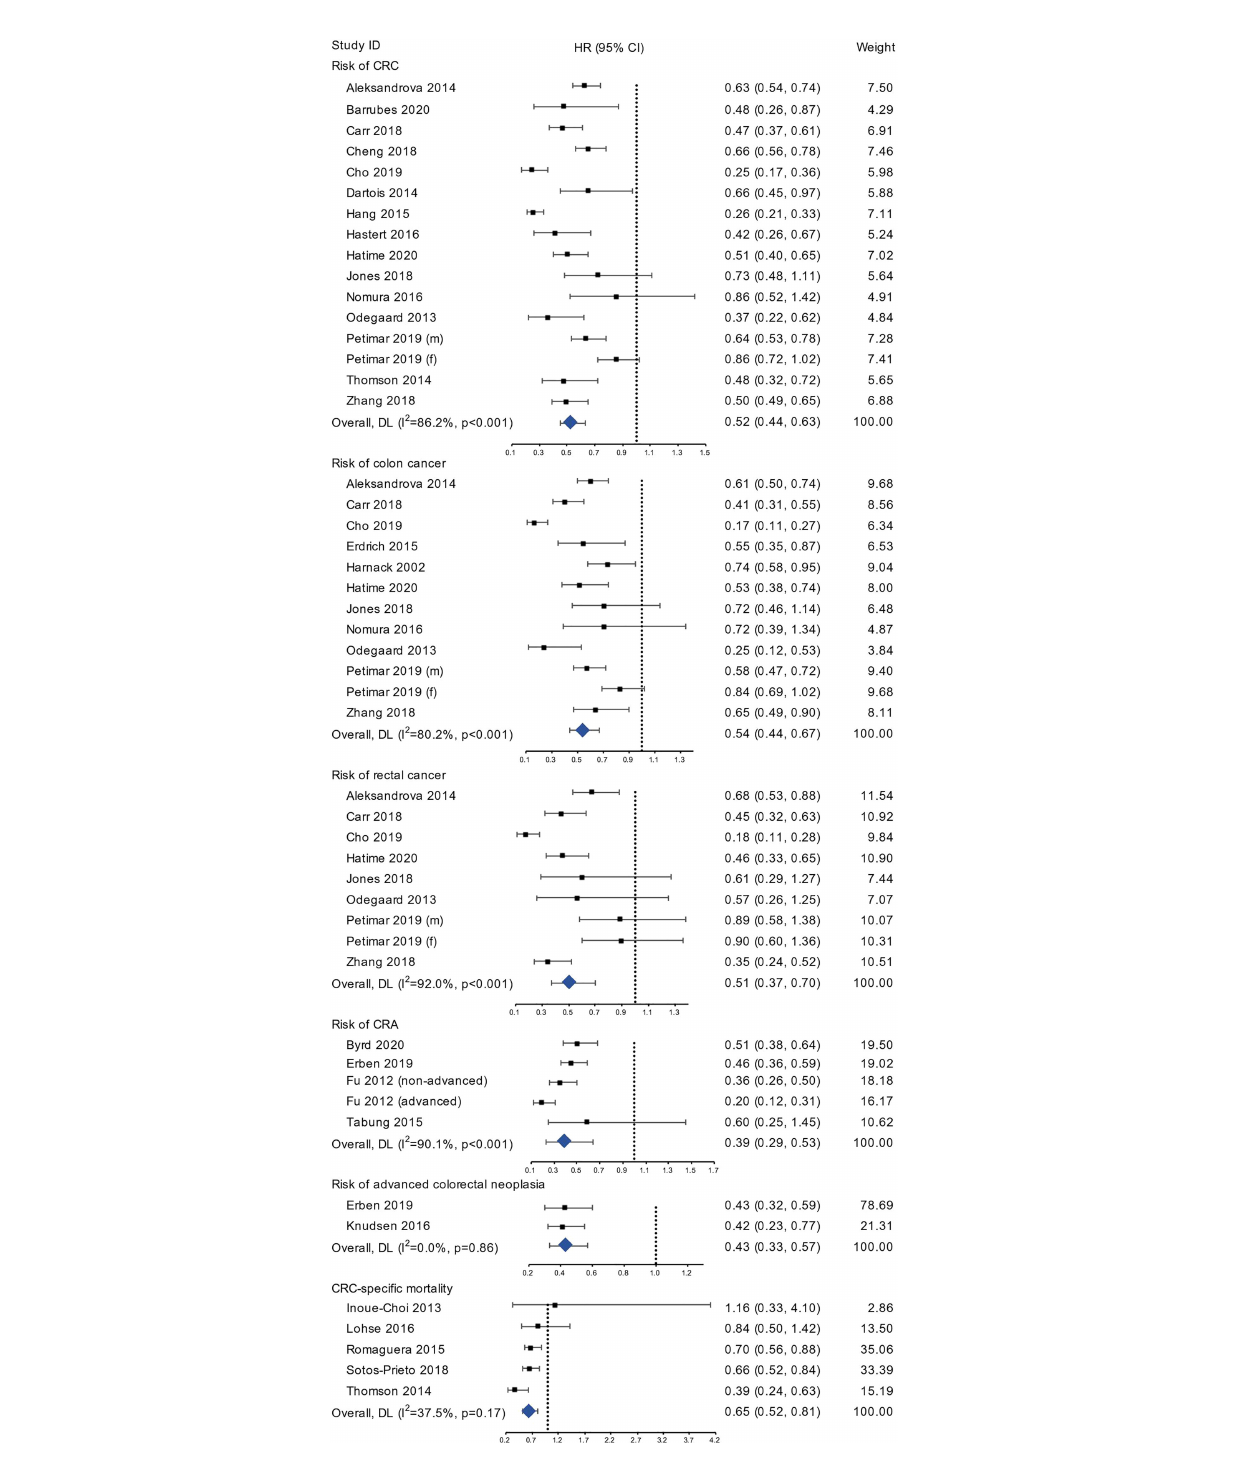
FIGURE 2 | The forest plots of risk of CRC, colon cancer, rectal cancer, CRA, advanced colorectal neoplasia, and CRC-speci fi c mortality.